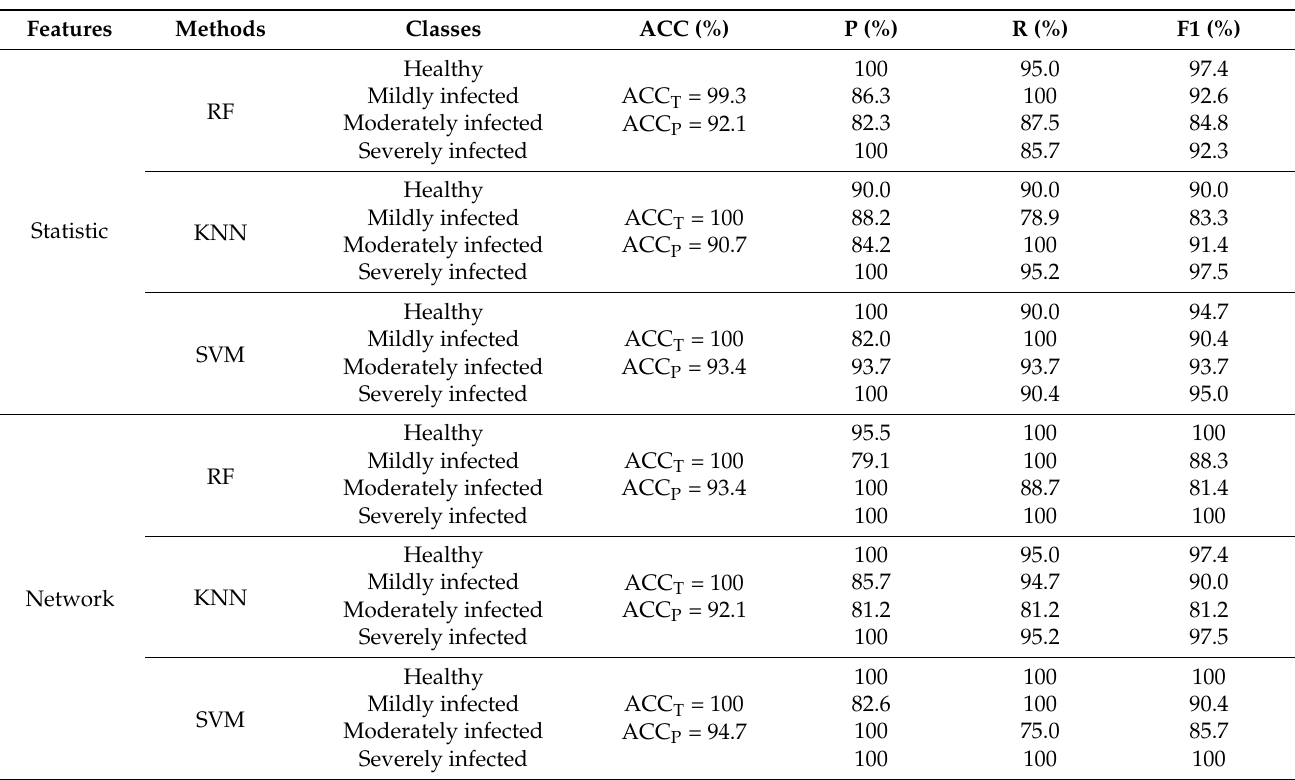
Table 2. Classi fi cation results of BRM infection degree in apples using RF, KNN, and SVM with HSI images of EWs.